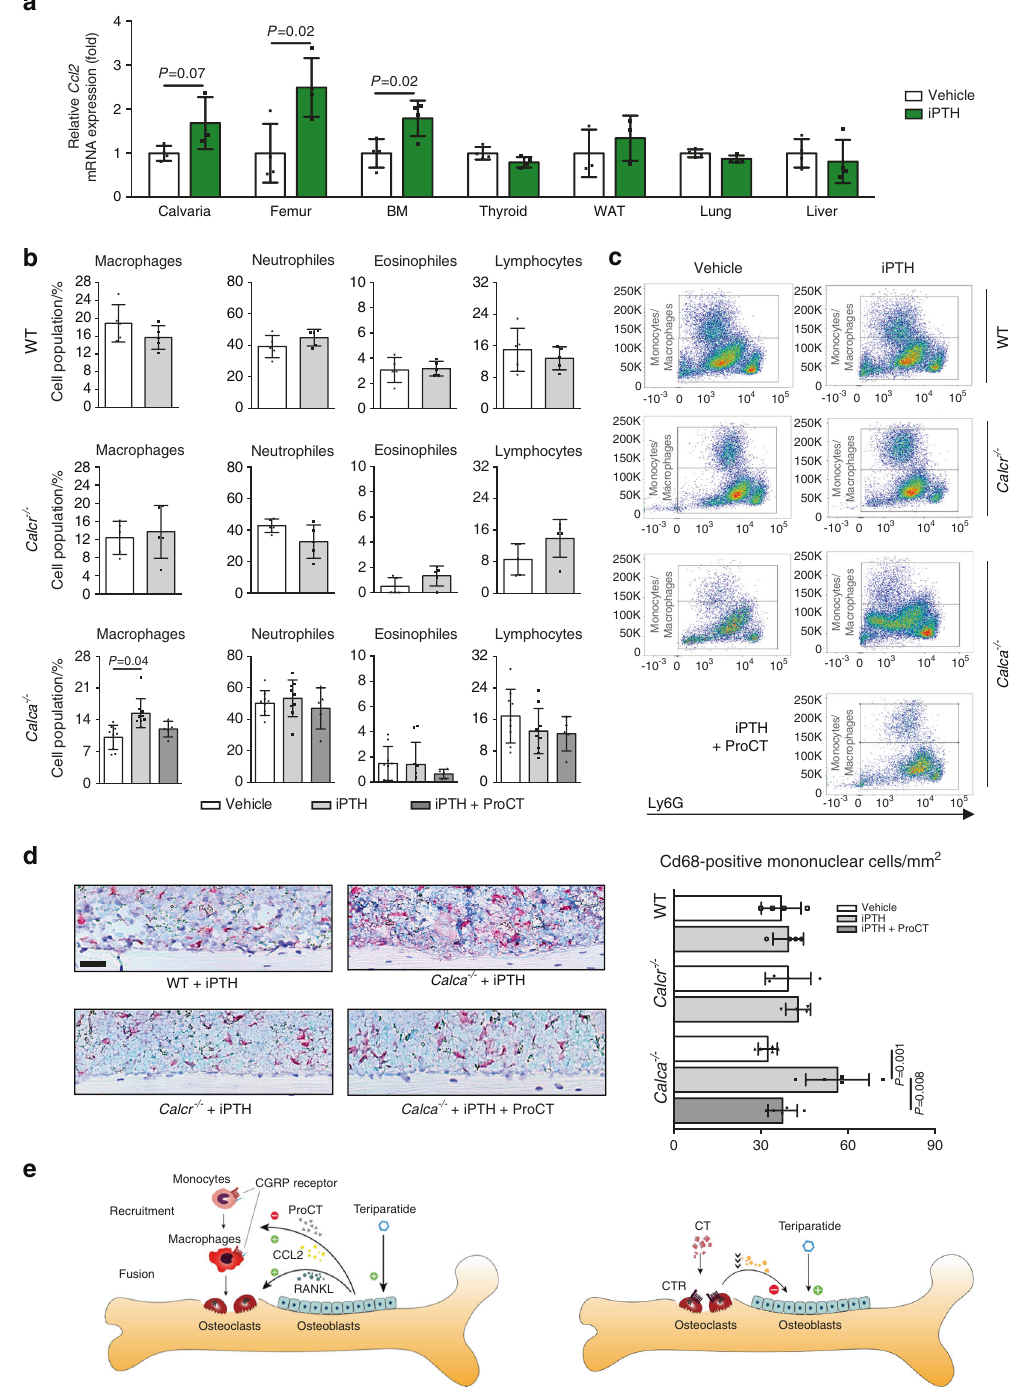
Fig. 8 Mice lacking ProCT display increased numbers of macrophages in the bone marrow after iPTH treatment. a Ccl2 expression levels (fold differences) in the indicated tissues following 4 weeks of iPTH treatment (100 μ g·kg − 1 ). BM = whole bone marrow. n = 3-4 mice per group (one-way ANOVA followed by Tukey ’ s post hoc test). b Flow cytometric analyses and ( c ) representative fl ow cytometry plots of the indicated cell populations in fl ushed bone marrow from mice of the indicated genotypes following 4 weeks of iPTH (100 μ g·kg − 1 ) and/or ProCT (10 μ g·kg − 1 ) treatment. Please also refer to Supplementary Fig. 8 for the gating strategy. n = 5 – 9 mice per group. For Calca − / − mice, the data were pooled from two independent experiments. d Representative images of immunohistochemical staining of tibia sections derived from the same mice using a Cd68-speci fi c antibody. Scale bar = 100 μ m. Quanti fi cation of intramedullary and endocortical Cd68- positive cells per bone marrow area is displayed on the right. n = 4-5 mice per group. In ( b – d ), one-way ANOVA followed by Tukey ’ s post hoc test was applied. e Schematic representation of the proposed function of Calca -derived peptides in regulating the therapeutic effect of iPTH. Left: iPTH (teriparatide) induces ProCT expression in osteoblasts, which impairs the recruitment of osteoclast precursors (i.e., monocytes and macrophages) to the bone surface and thus inhibits bone resorption. Right: Circulating CT impairs the osteoanabolic effect of iPTH based on tonic inhibition of bone formation, presumably via